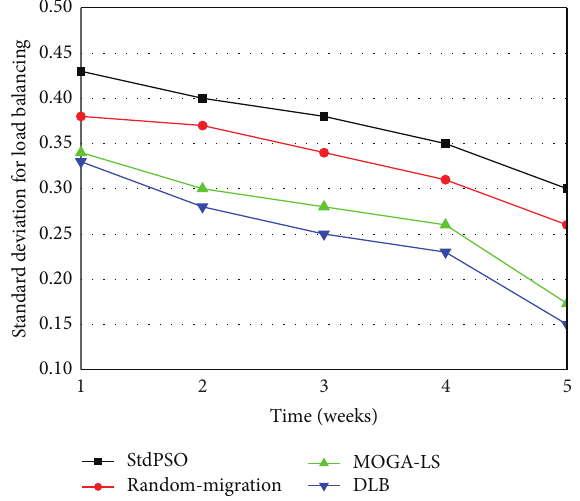
Figure 7: Comparison of StdPSO, random-migration, DLB, and MOGA-LS in load